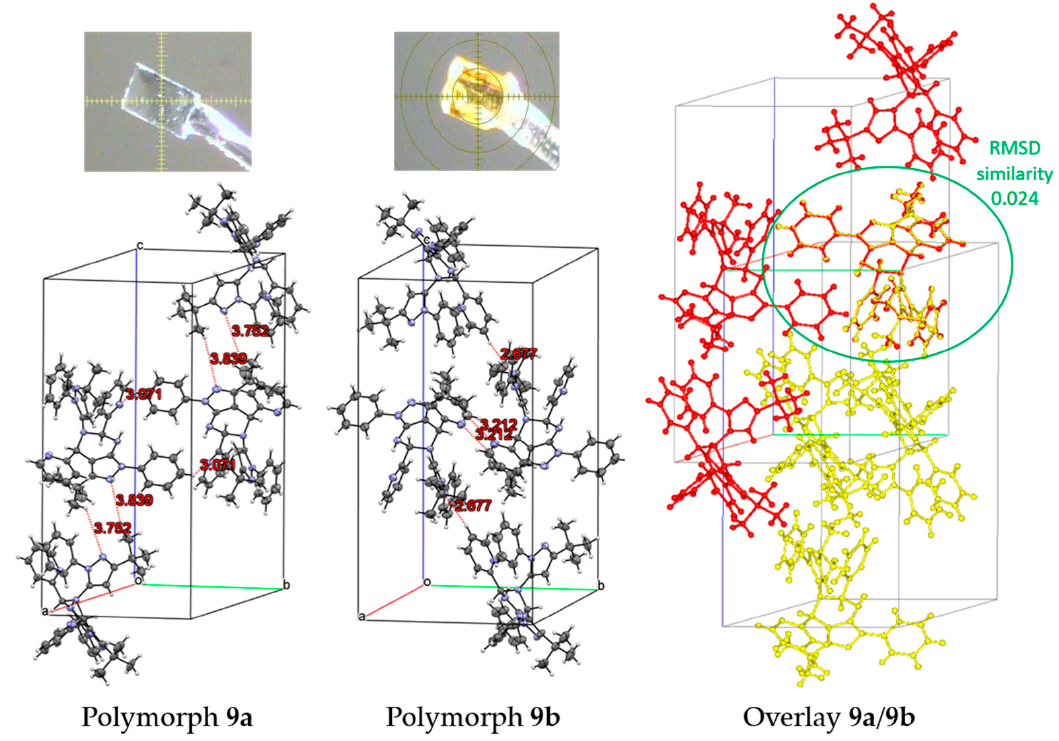
Figure 7. Crystal packing in polymorphs 9a and 9b along with the corresponding plot overlay ( 9a in red and 9b in yellow). Photographs of crystal samples used for X-ray diffractions measurements are included as inserts in this figure.